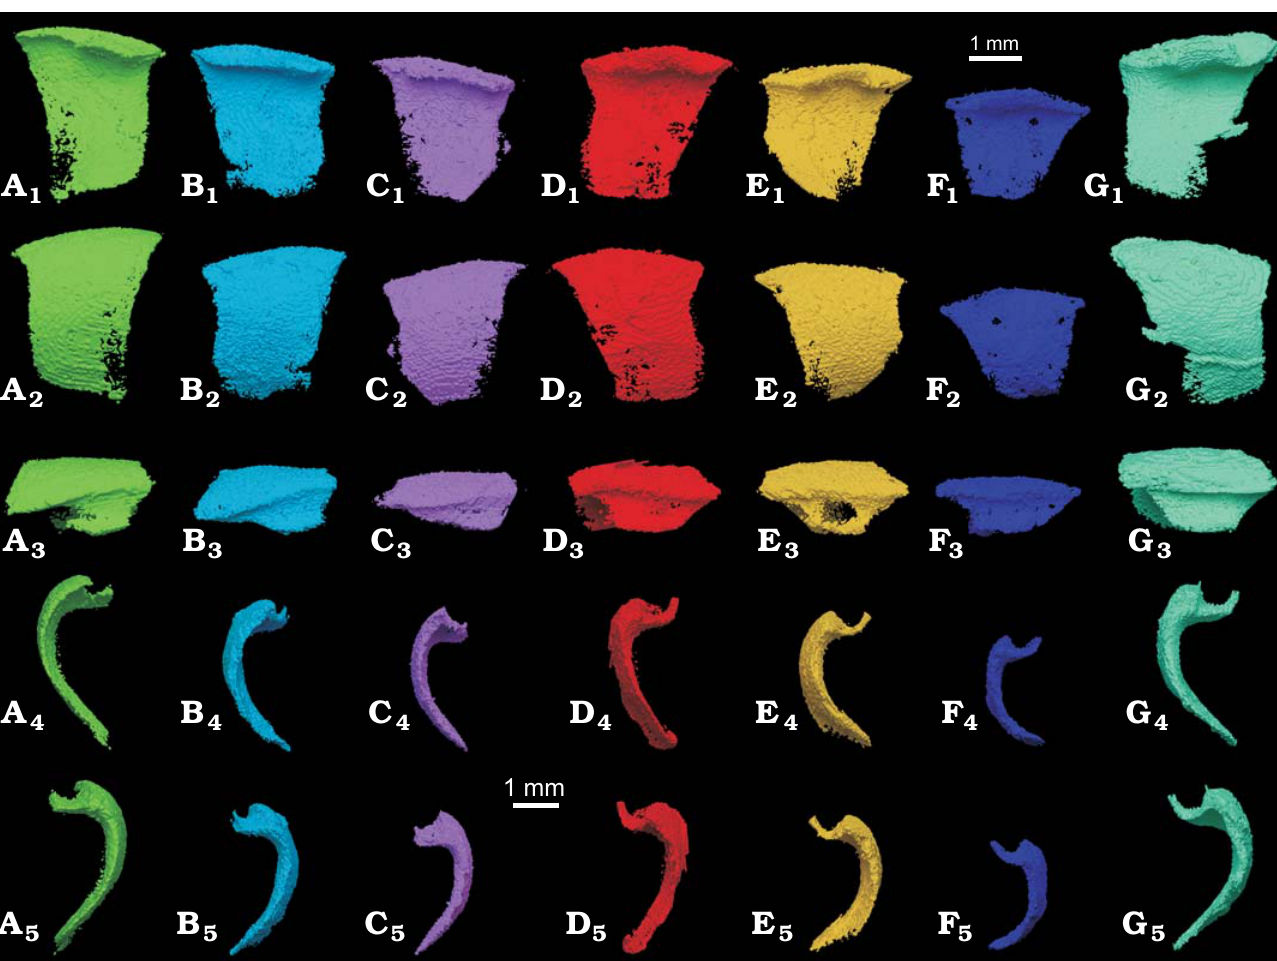
Fig. 4. Overview of the almost complete sclerites from the 3D-analysis (orthographic perspective). Group I: sclerites 1, 4, 6 ( A – C ) and group II: sclerites 2, 5, 7, 10 ( D – G ). Internal (A 1 –G 1 ), lateral (A 2 –G 2 ), dorsal (A 3 –G 3 ), posterior (A 4 –G 4 ), and anterior (A 5 –G 5 )